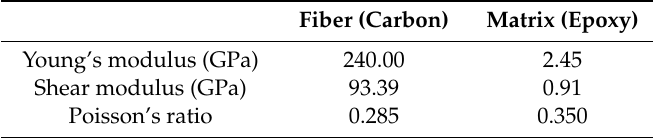
Table 1. Material properties of the fiber and matrix (TR50S / Epoxy).